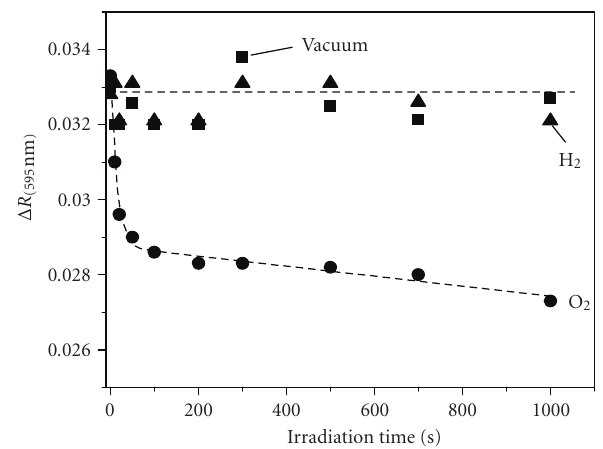
Figure 16: Absorption spectra of photoinduced color centers in N- doped TiO 2 obtained after pre-irradiation at 546 nm in vacuum, in the presence of O 2 and H 2 . Reproduced with permission from [71].